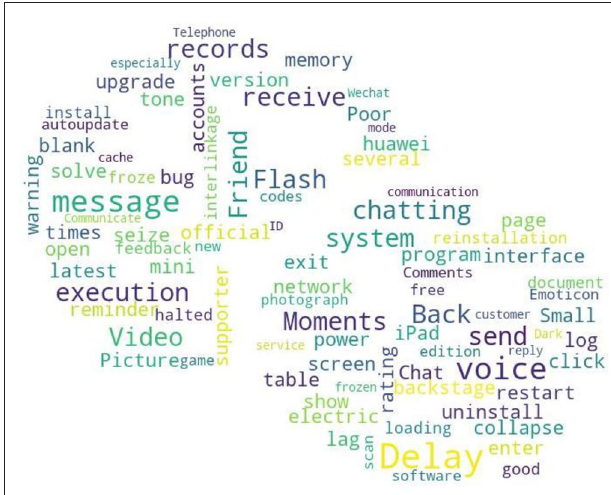
FIGURE 5 | Availability of WeChat.